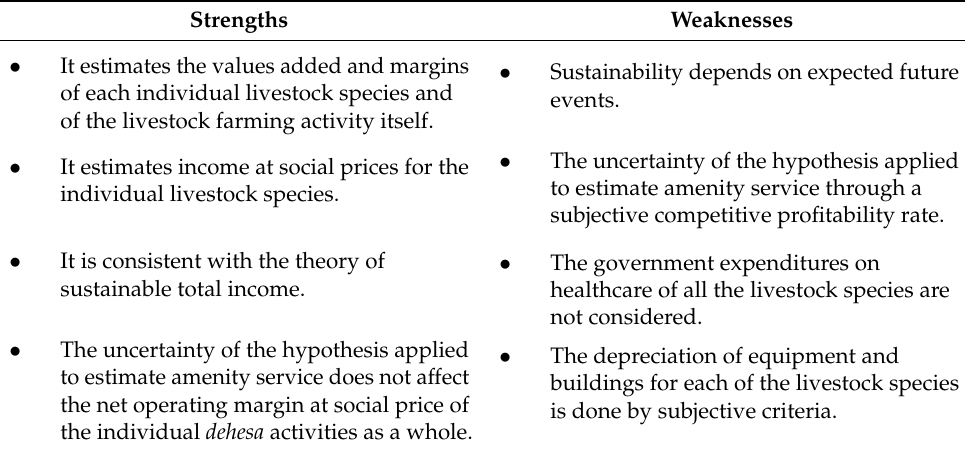
Table 10. Strengths and weaknesses of the AAS applied on large privately owned case-study dehesas in